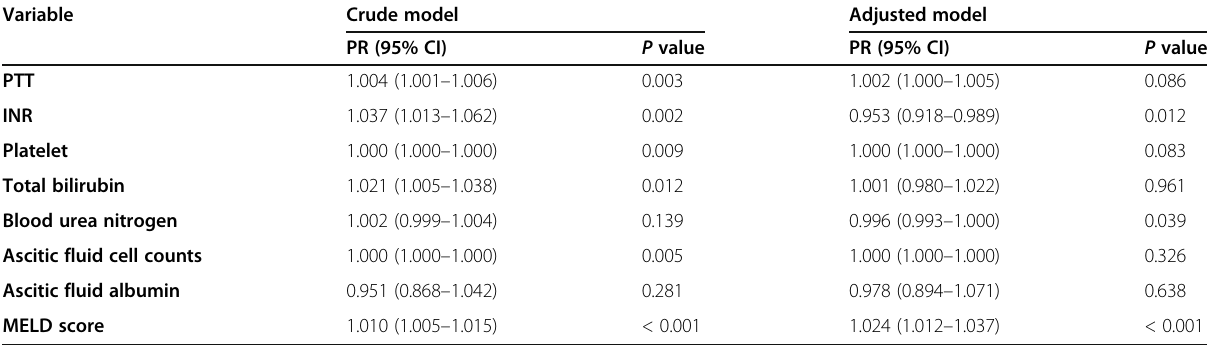
Table 5 Robust Poisson regression models estimating prevalence ratio (PR) and 95% confidence interval (CI) to evaluate the association of various laboratory parameters on the types of Budd – Chiari